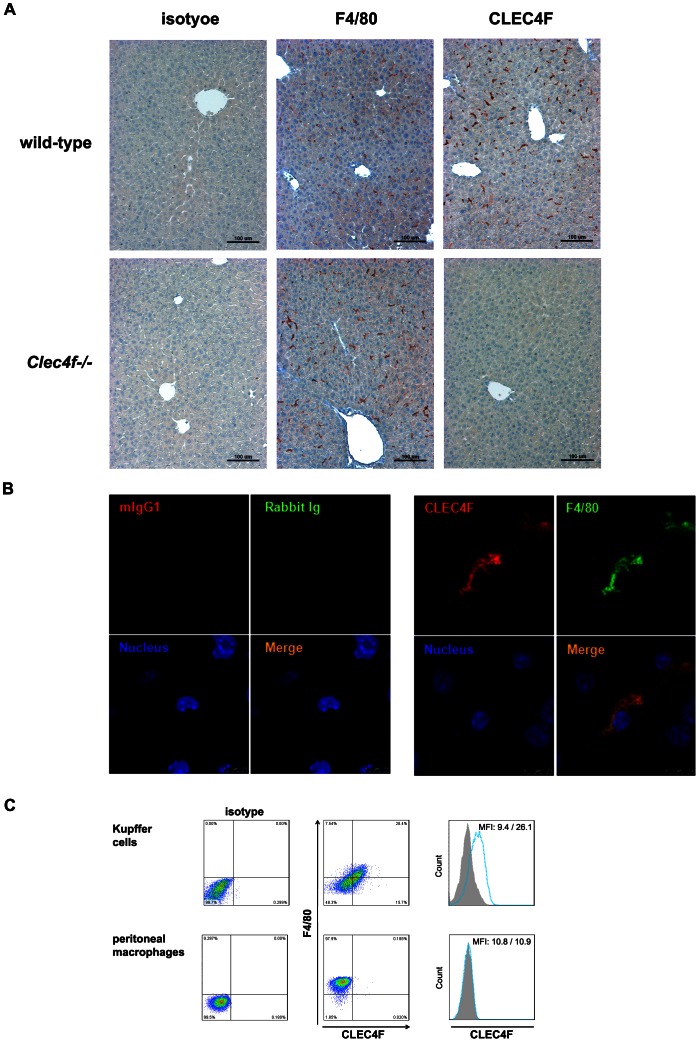
CLEC4F is co-expressed with F4/80 on liver Kupffer cells.(A) CLEC4F and F4/80 immunohistochemistry of parafilm-embedded liver sections from wild-type and Clec4f−/− mice. (B) Double immunofluorescence of CLEC4F and F4/80 in wild-type livers was performed. Nuclei were counterstained with Hoechst 33342. Signals were determined by confocal microscope (magnification 10×63). (C) Coexpression of CLEC4F and F4/80 on Kupffer cells, but not peritoneal macrophages. Cells were double stained with Alexa Fluor 647-conjugated anti-F4/80 and PE-conjugated anti-CLEC4F mAb. Alexa Fluor 647-conjugated rat IgG2b and PE-conjugated mIgG1 were used as isotype controls.